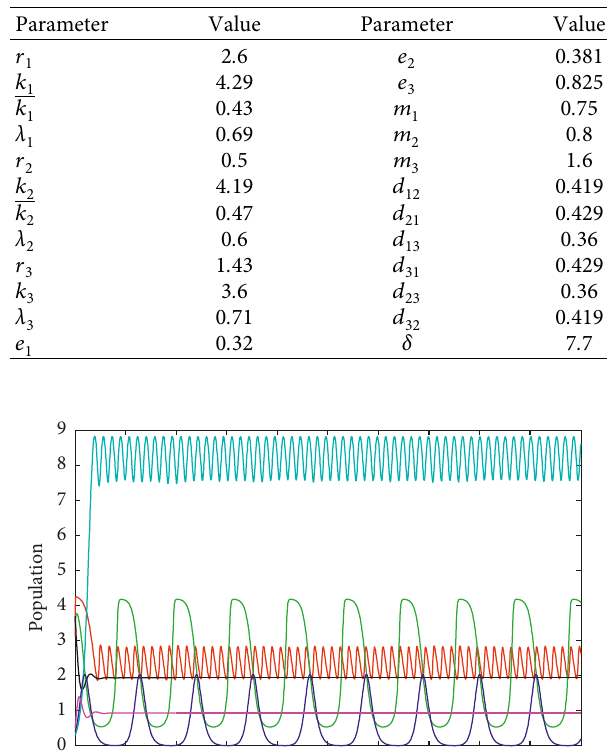
Table 1: Numerical values of the model parameters.